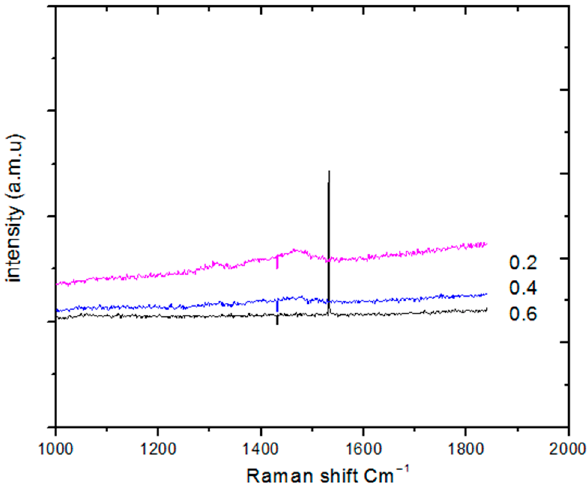
Figure 4. Raman spectroscopy of doped cobalt chromites Co 1-x Ni x Cr 2 O 4 .